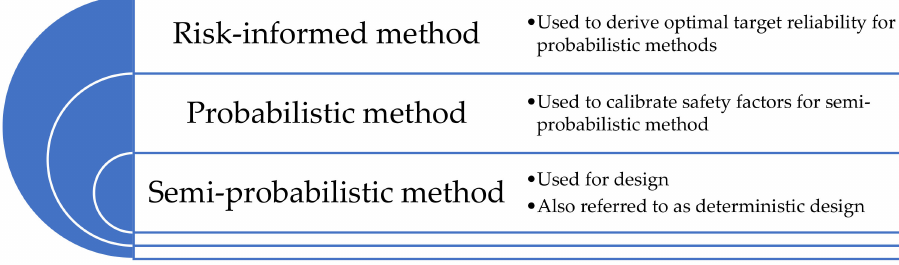
Figure 1. Overview of assessment